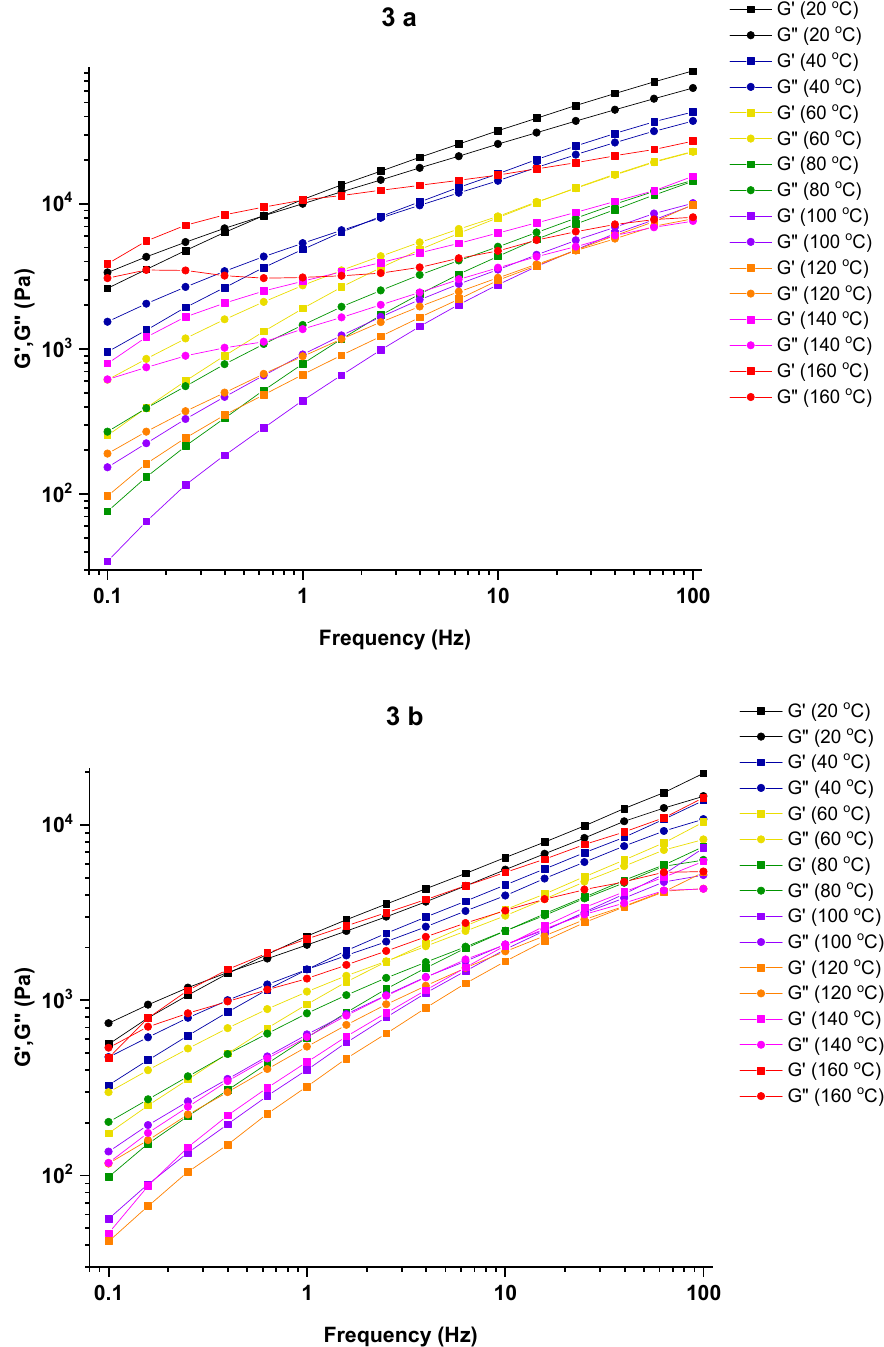
Figure 16. Frequency dependences of G ′ , and G ″ for polymers 3 a ( top ) and 3 b ( bottom ) at different temperatures.